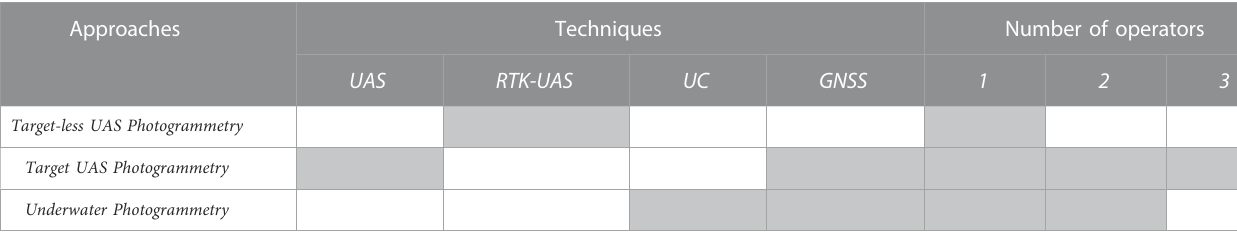
TABLE 1 Techniques and number of operators employed for each survey. UAS: Unmanned Aircraft Systems. RTK: Real Time Kinematic. UC: Underwater Camera. GNSS: Global Navigation Satellite System. Approaches